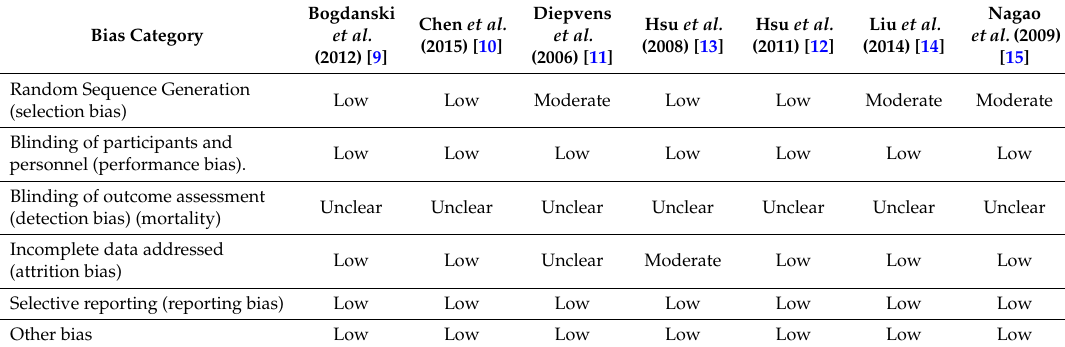
Table 2. Risk of bias summary for studies included in this systematic